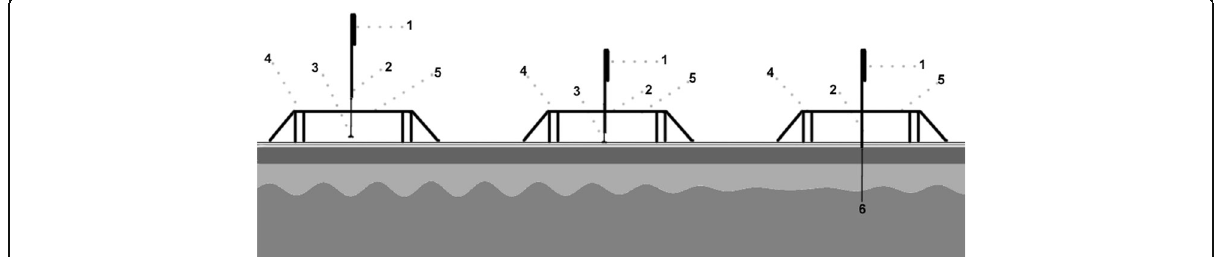
Fig. 2 Structure of Streitberger needle. (1) Needle handle (2) Needle rod (3) Blunt tip of the placebo needle (4) Plastic ring (5) Plastic cover (6) Sharp tip of the real needle